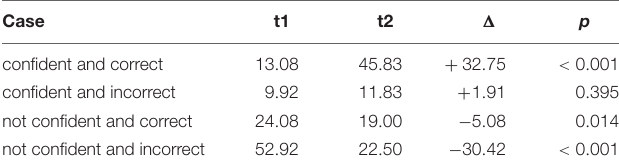
TABLE 3 | Average proportions (in %) of the four combinations at t1 and